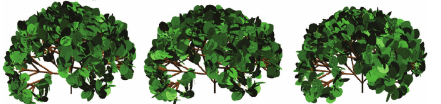
Figure 10: Year Seven motion in response to wind, images taken four seconds apart.